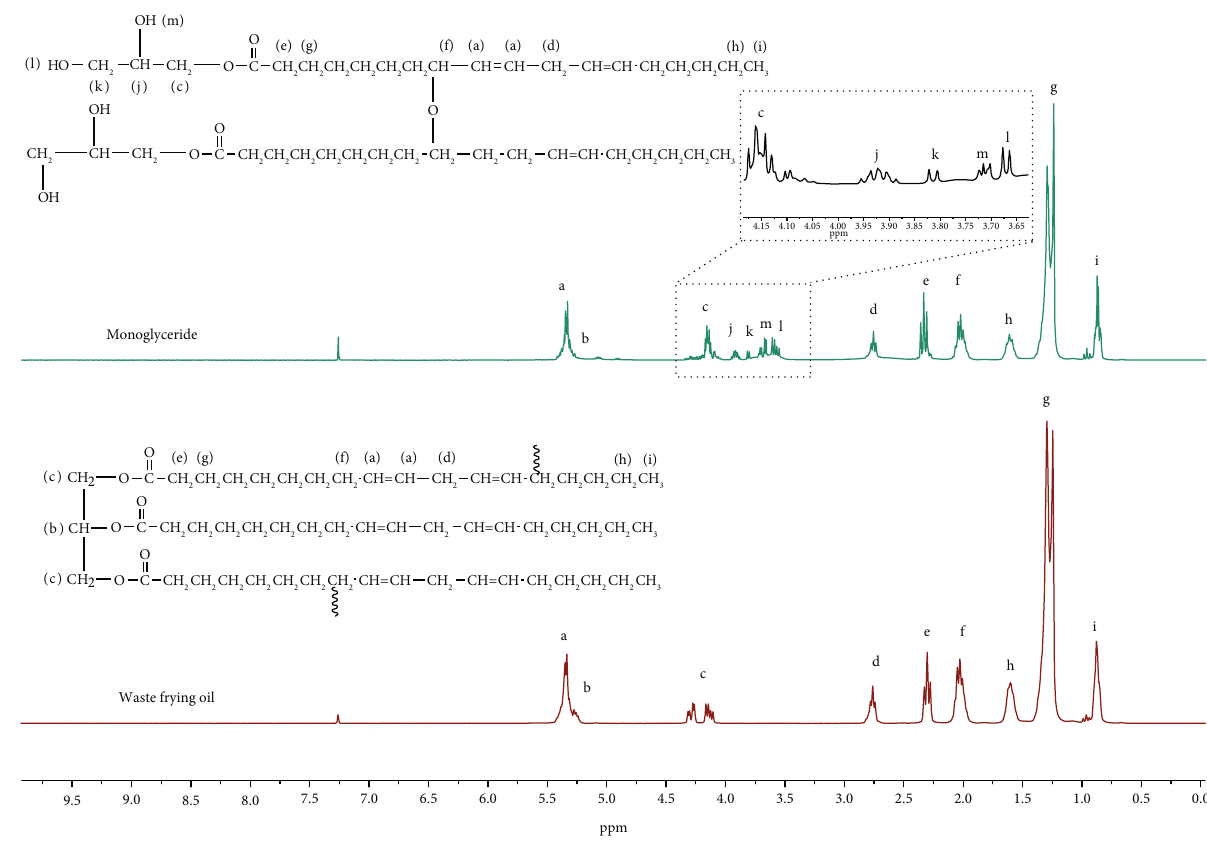
Figure 2: 1 H-NMR spectra of waste frying oil and the as-prepared monoglyceride.